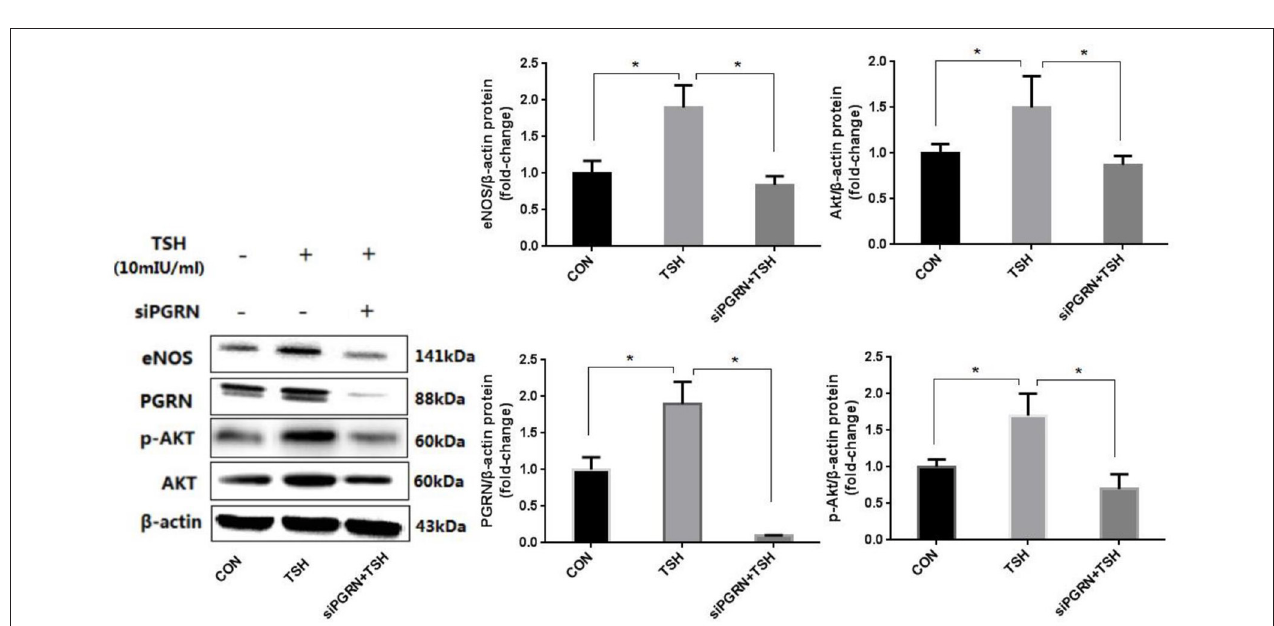
FIGURE 7 | PGRN inhibition can prevent eNOS upregulation induced by TSH in HUVECs. siPGRN was used to inhibit the expression of PGRN in HUVECs; the concentration of TSH was 10 mIU/ml, stimulating for 24h; Data were obtained from three separate experiments. * P < 0.05, when compared with the control.